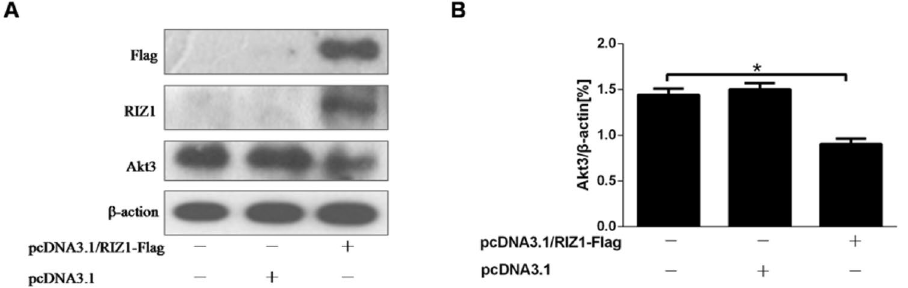
Figure 1. RIZ1 overexpression on Akt3 protein levels. ( A ) The western blotting analysis for Flag, RIZ1, Akt3 and β -actin. ( B ) Results from densitometric analysis of Akt3 protein level relative to β -actin from 3 independent experiments was shown as means ± SD; * p < 0.05.